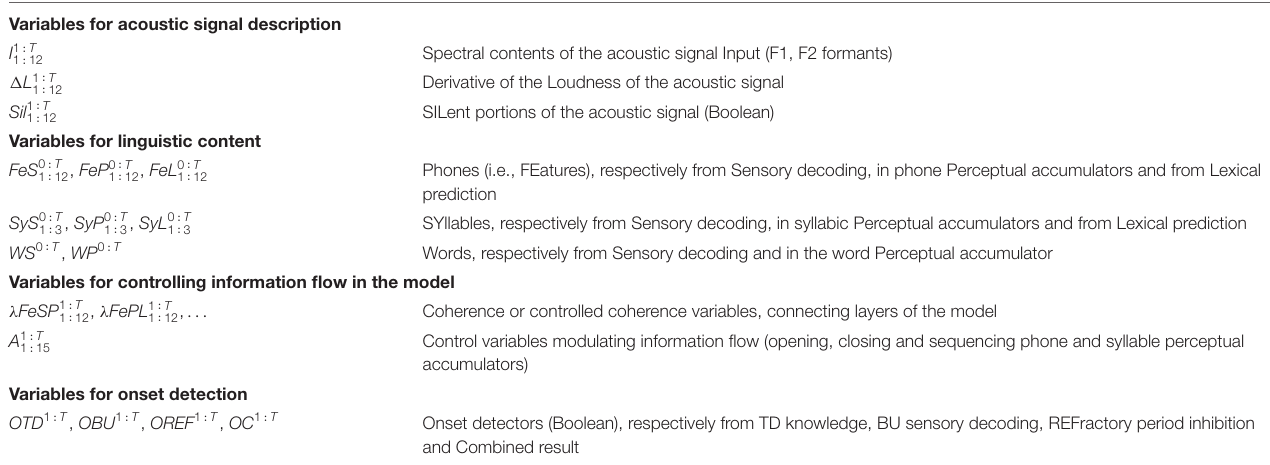
TABLE 1 | Summary of symbols: variable names and their interpretation. Variables for acoustic signal